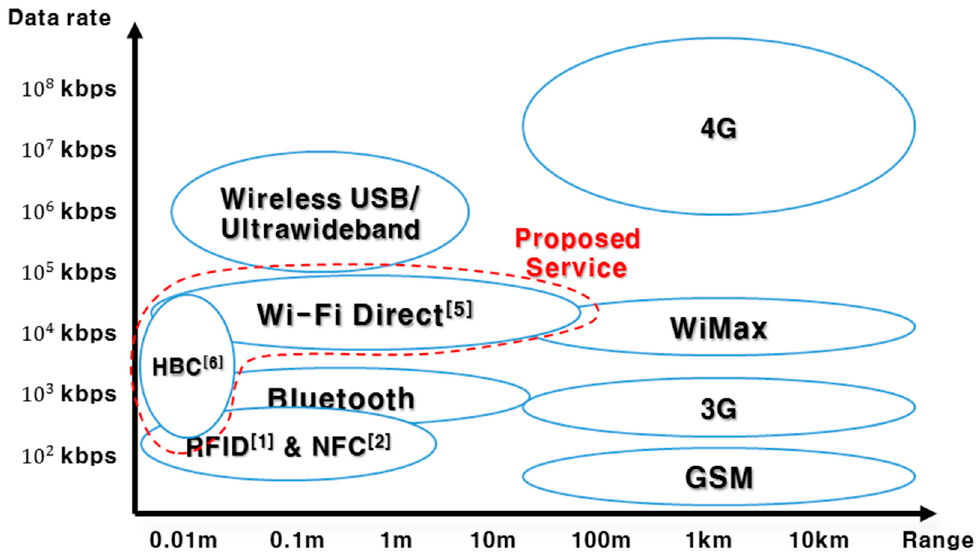
Figure 2. Touch-based Dual-Band Communication Service Coverage Area.